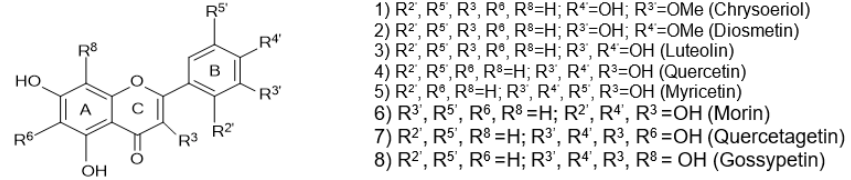
Figure 1. Chemical structures of the studied Figure 53. Chemical structures of the studied flavonoids.